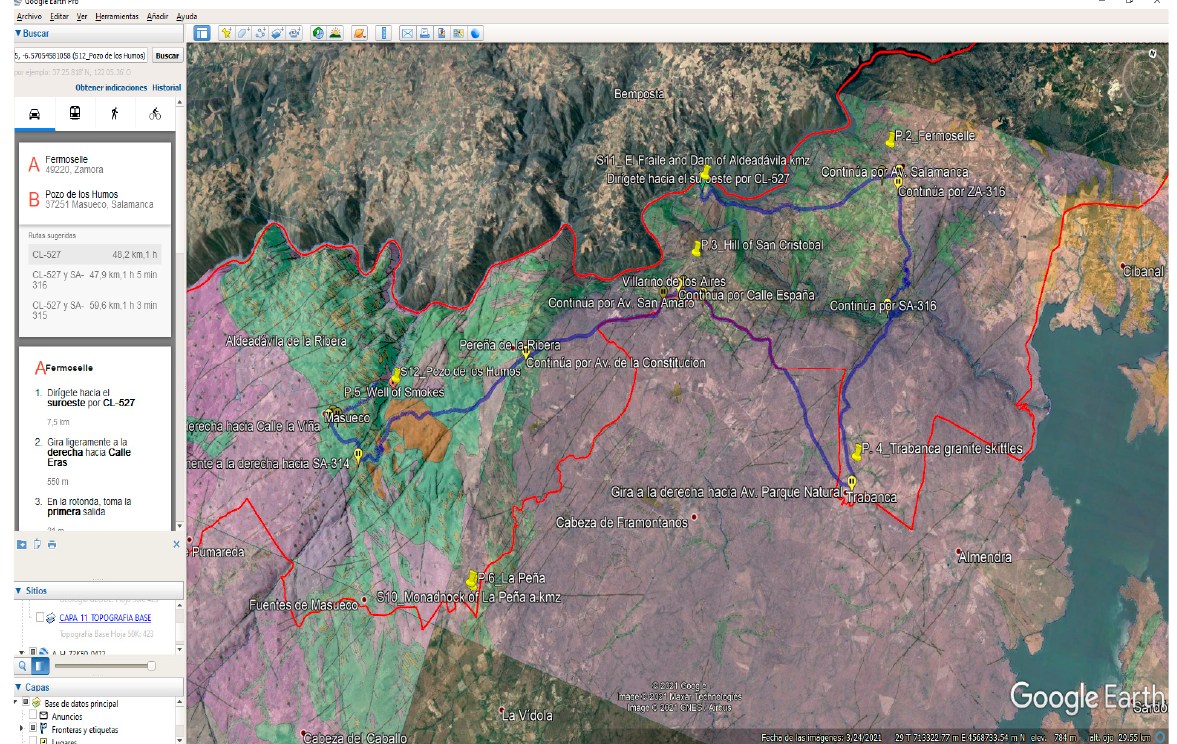
Figure 6. Capture of one of the possible routes that was generated by Google Earth (blue line) on the geological cartography with transparency on the orthophotography. Route from Mirador del Fraile to the Pozo de los Humos. Red line: limits of the Arribes del Duero Natural Park. By interacting with the Street View application of Google Maps, structures or outcrops can be viewed “in situ” (Fig. 7). In addition, a topographic profile of the route can be generated, allowing one to previously assess its complexity (Fig. 8).